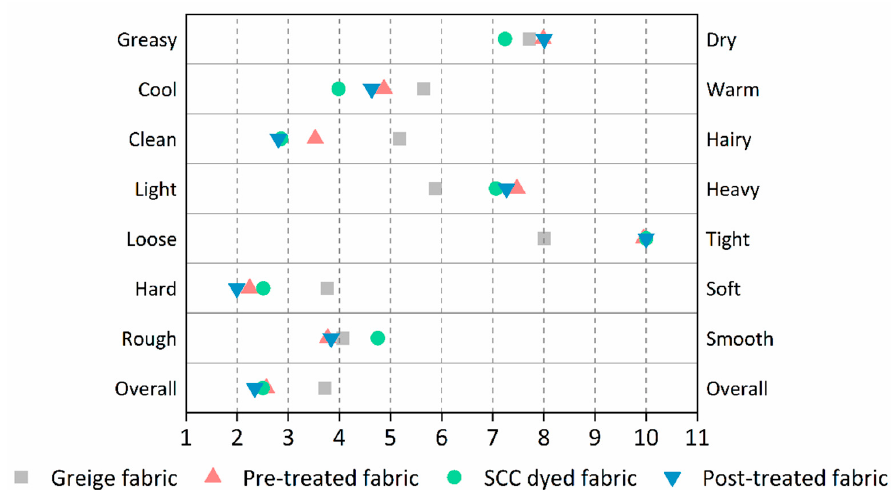
Materials 2020 , 13 , x FOR PEER REVIEW